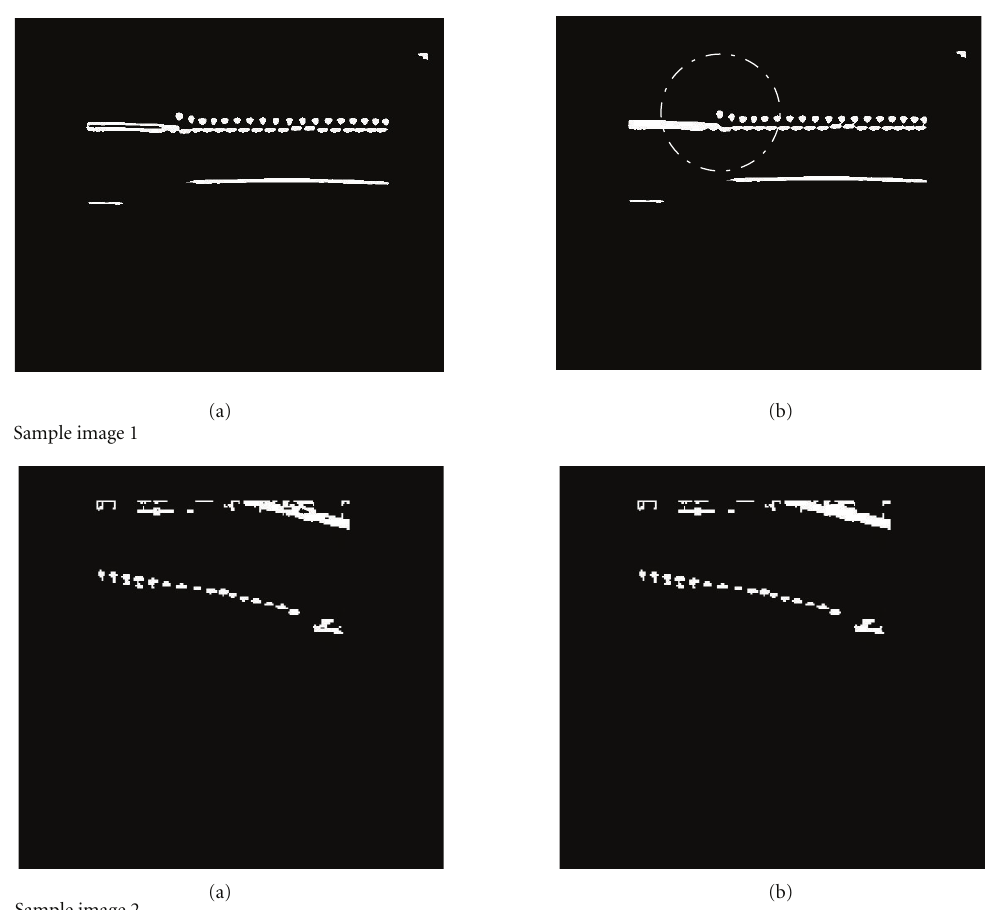
Figure 7: The e ff ect of morphology on two sample images. (a) Before morphology application, (b) after morphology.